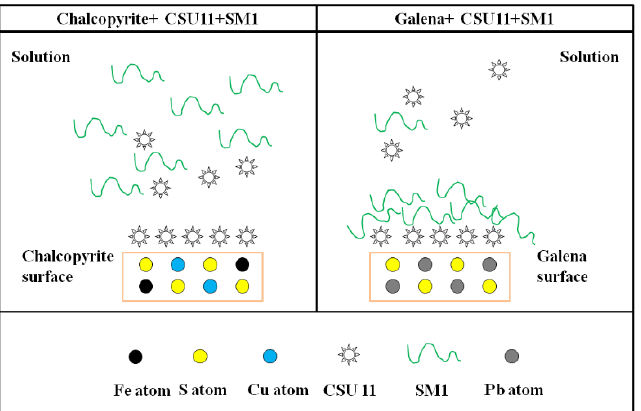
Figure 12. Schematic diagram of the adsorption model of the collector CSU11 and the depressant SM1 onto the mineral surfaces.